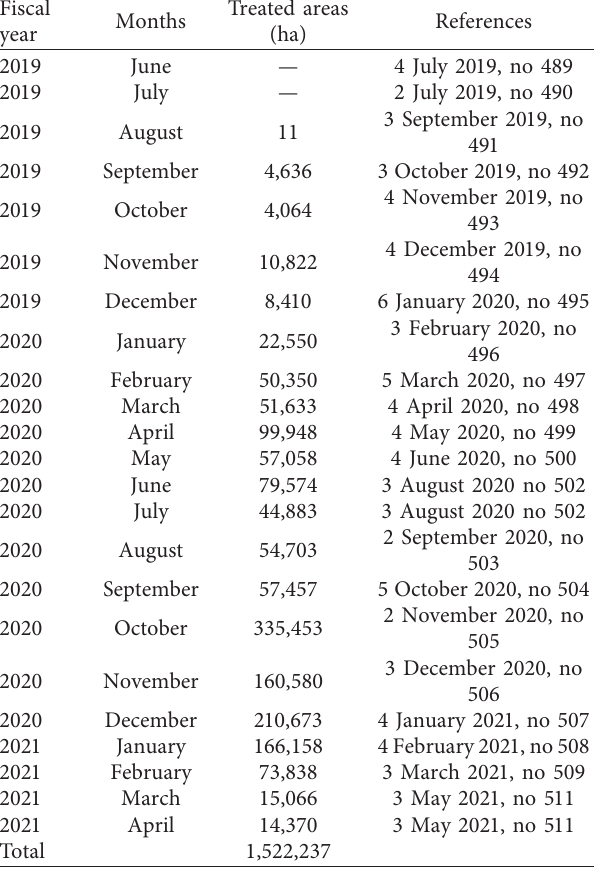
Table 1: Pesticide treated areas since August 2019 up to May